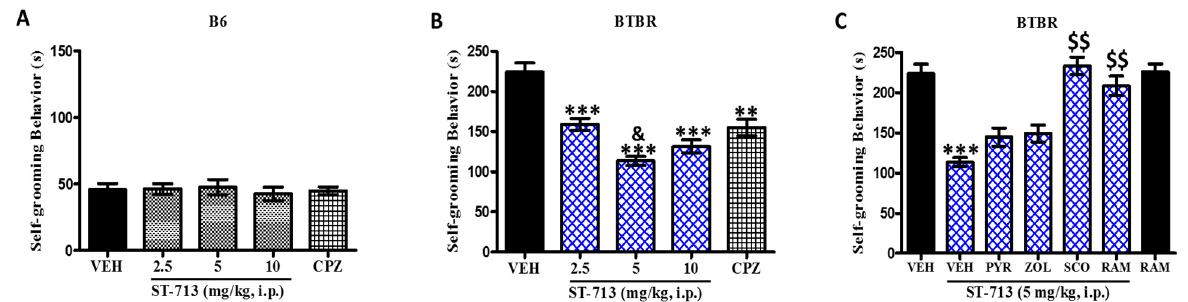
Figure 1. ST-713 reduced repetitive self-grooming behaviors in BTBR mice. The total duration of the self-grooming experiment was 10 min. No significant difference was found in the amount of time spent in self-grooming for B6 mice irrespective of their chronic systemic treatments (21 days) with VEH, ST-713 (2.5–10 mg/kg), or chlorpromazine (CPZ, 1.5 mg/kg) ( A ). BTBR mice treated with the multiple-active test compound at varying dosages, or reference medication chlorpromazine ( B ). The results observed for abrogative properties of pyrilamine (PYR, 10 mg/kg), zolantidine (ZOL, 10 mg/kg), scopolamine (SCO, 0.3 mg/kg), or ( R )- α -methylhistamine (RAM, 10 mg/kg) on the enhancements obtained with ST-713 on repetitive self-grooming behaviors of mice with ASD-like behaviors ( C ). Figures show mean ± SEM (n = 6). ** p < 0.01 vs. VEH-receiving BTBR group. *** p < 0.001 vs. VEH-treated BTBR group. & p < 0.01 vs. chlorpromazine-treated BTBR group. $$ p < 0.01 vs. ST-713-(5 mg)-receiving BTBR group.